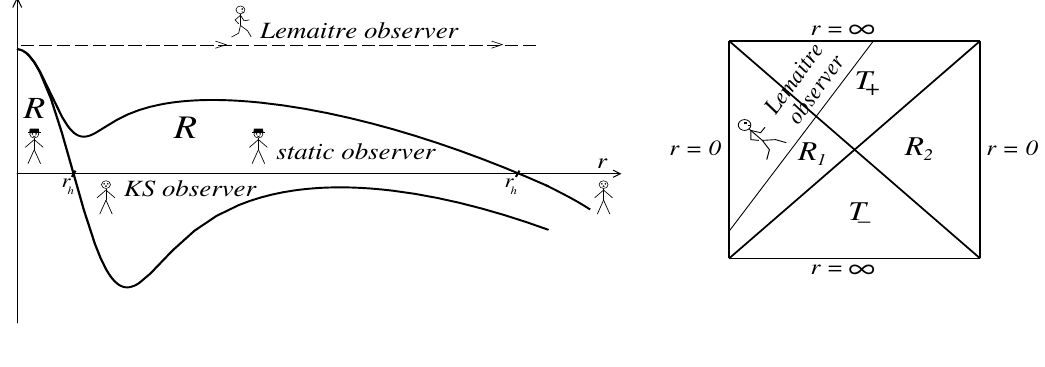
Figure 3. One-horizon spacetimes with vacuum dark